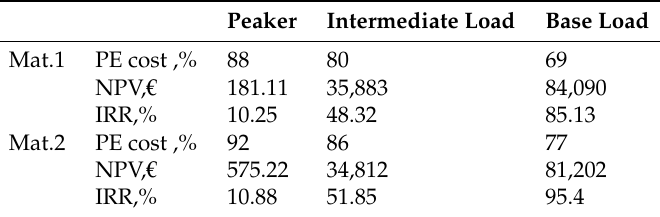
Table 10. TEG economic performance results based on the reference case presented in Table